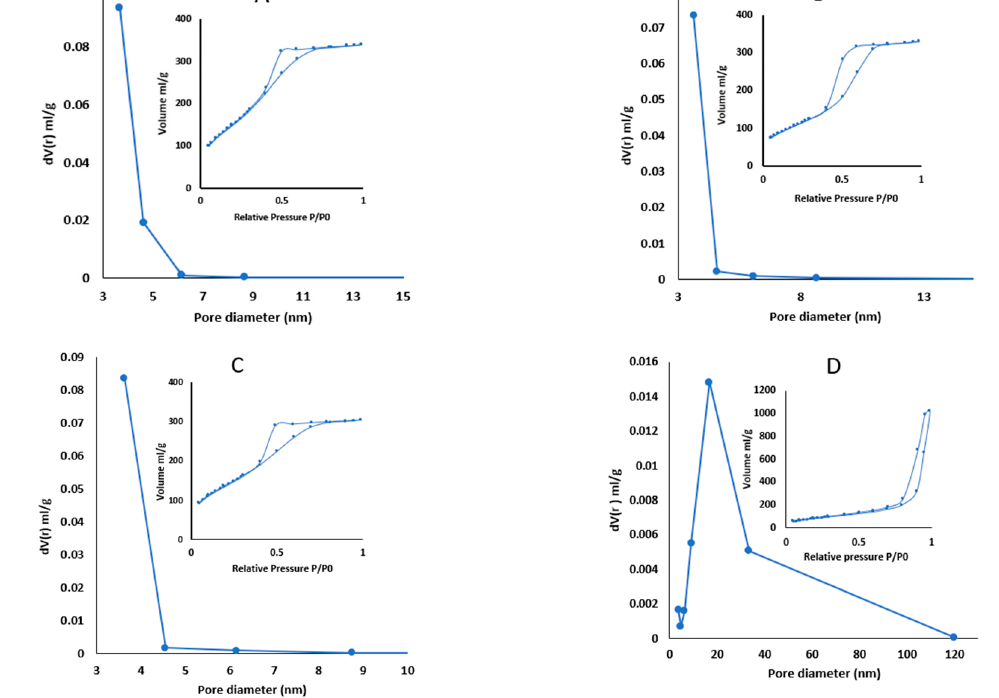
Figure 1. Pore size distribution of different SilverSil xerogels: A (90:10) (inset Brunauer–Emmett– Teller (BET) isotherm of the same matrix), B (70:30), C (50:50) and D (30:70).